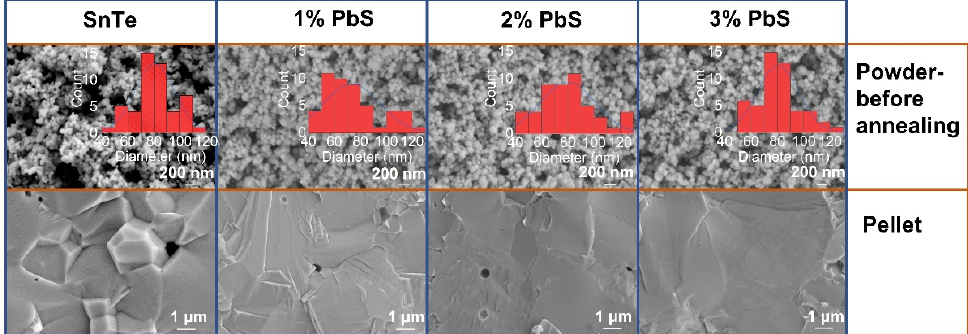
Figure 4. The SEM images of powders before annealing; and pellets.